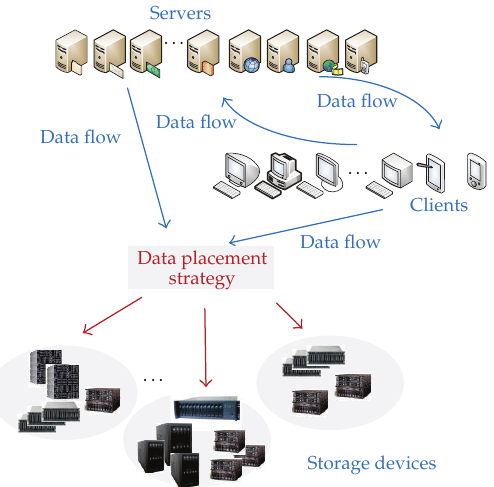
Figure 2: Hierarchical